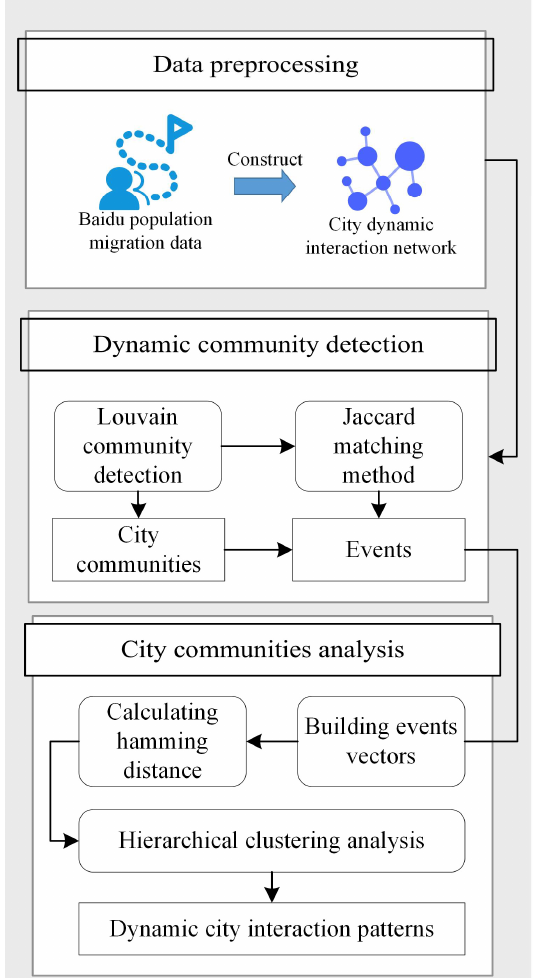
Figure 2. The technical route diagram.